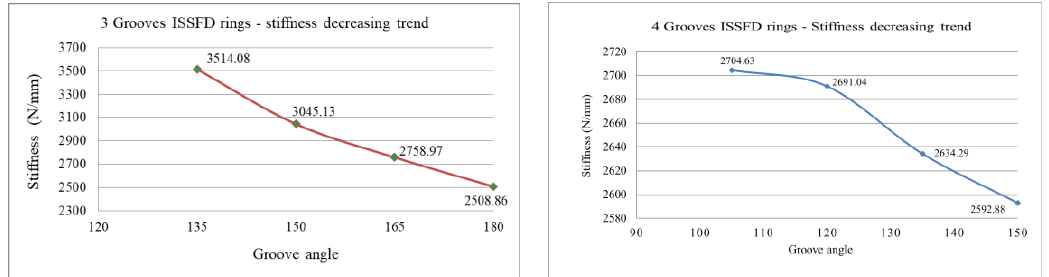
Figure 9: Stiffness variation with groove angle/groove length & overlap angle of grooves